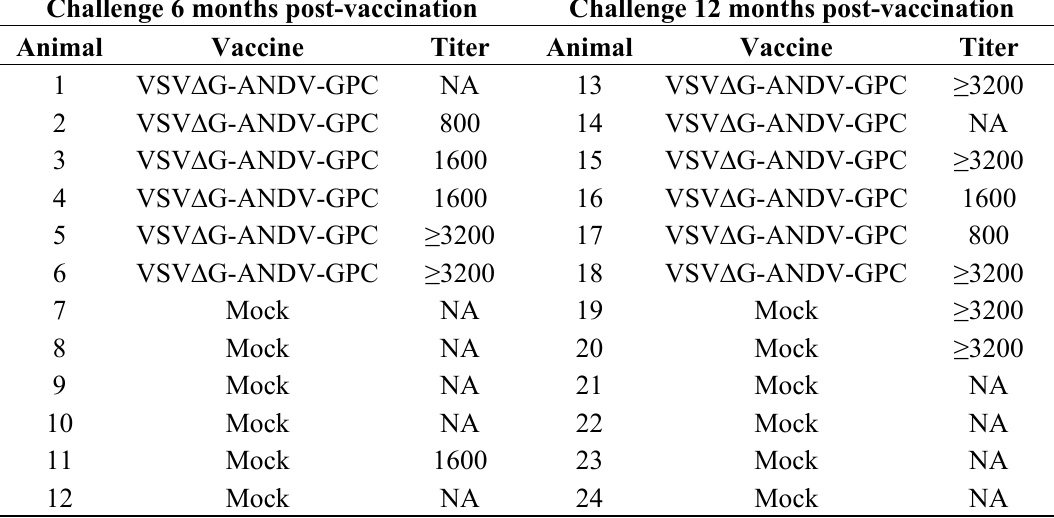
Table 1. Anti-ANDV N ELISA titers in hamsters that survived i.n. challenge with 200 FFU of